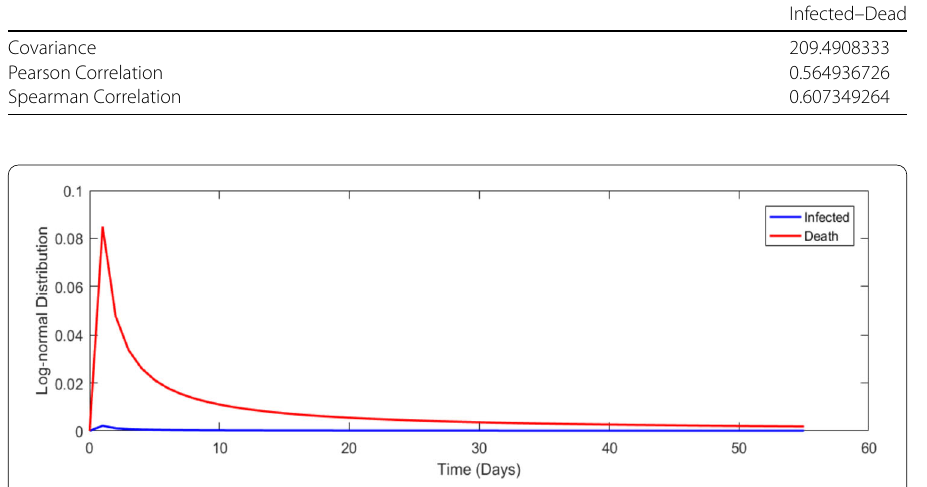
Figure 31 Lognormal distribution for all cases in South